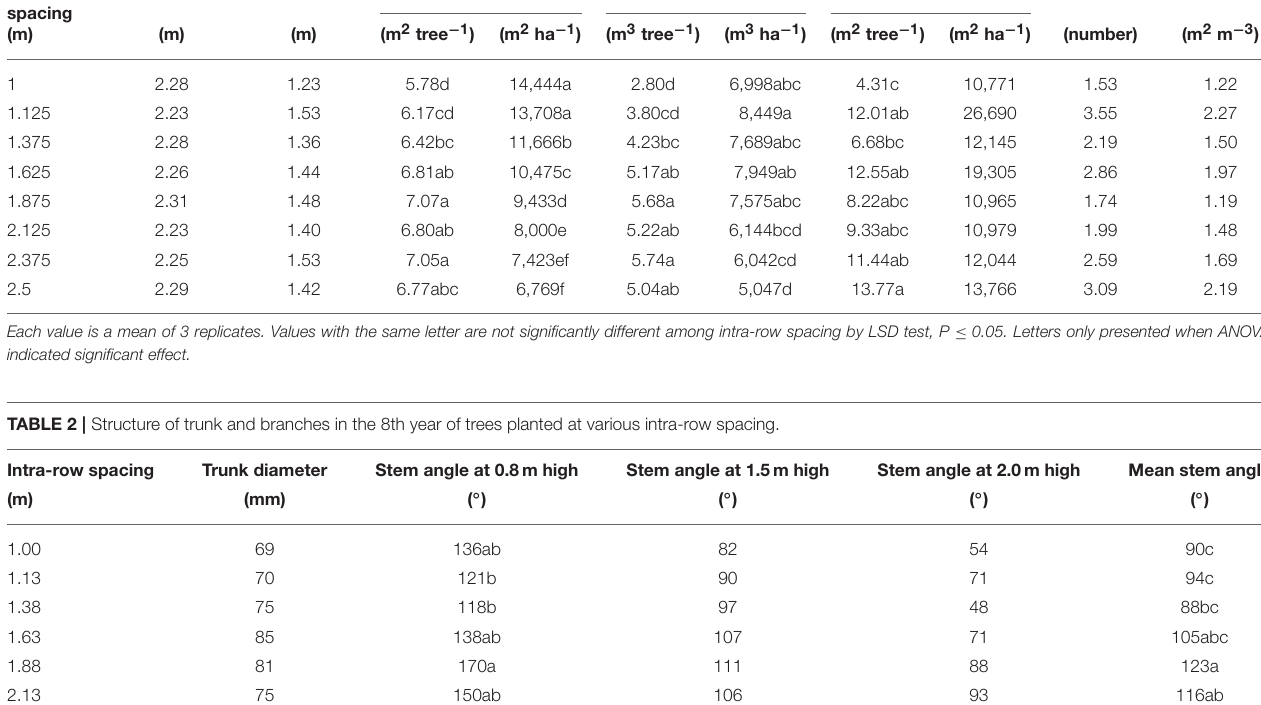
TABLE 1 | Characteristics of hedgerow trees in the 8th year after planting at various intra-row spacing. Intra-row spacing